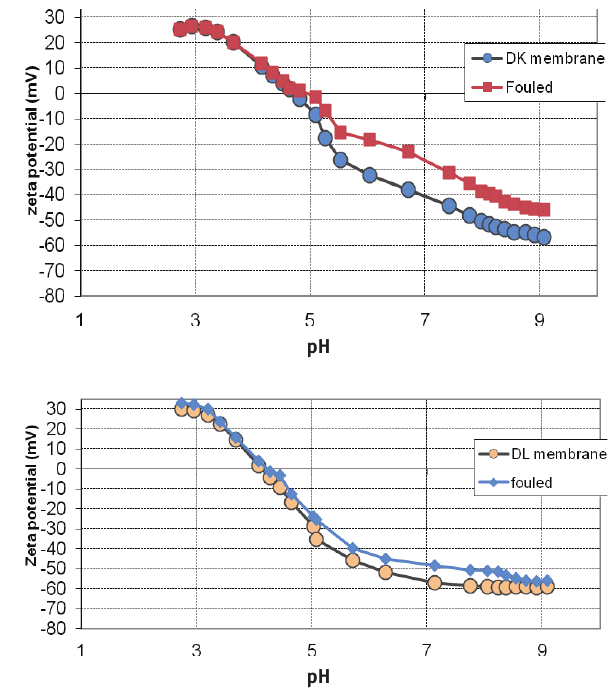
Figure 5: Zeta-potential as a function of pH (KCl = 0.001M) for DK membrane (above) and DL membrane (below), O -virgin,